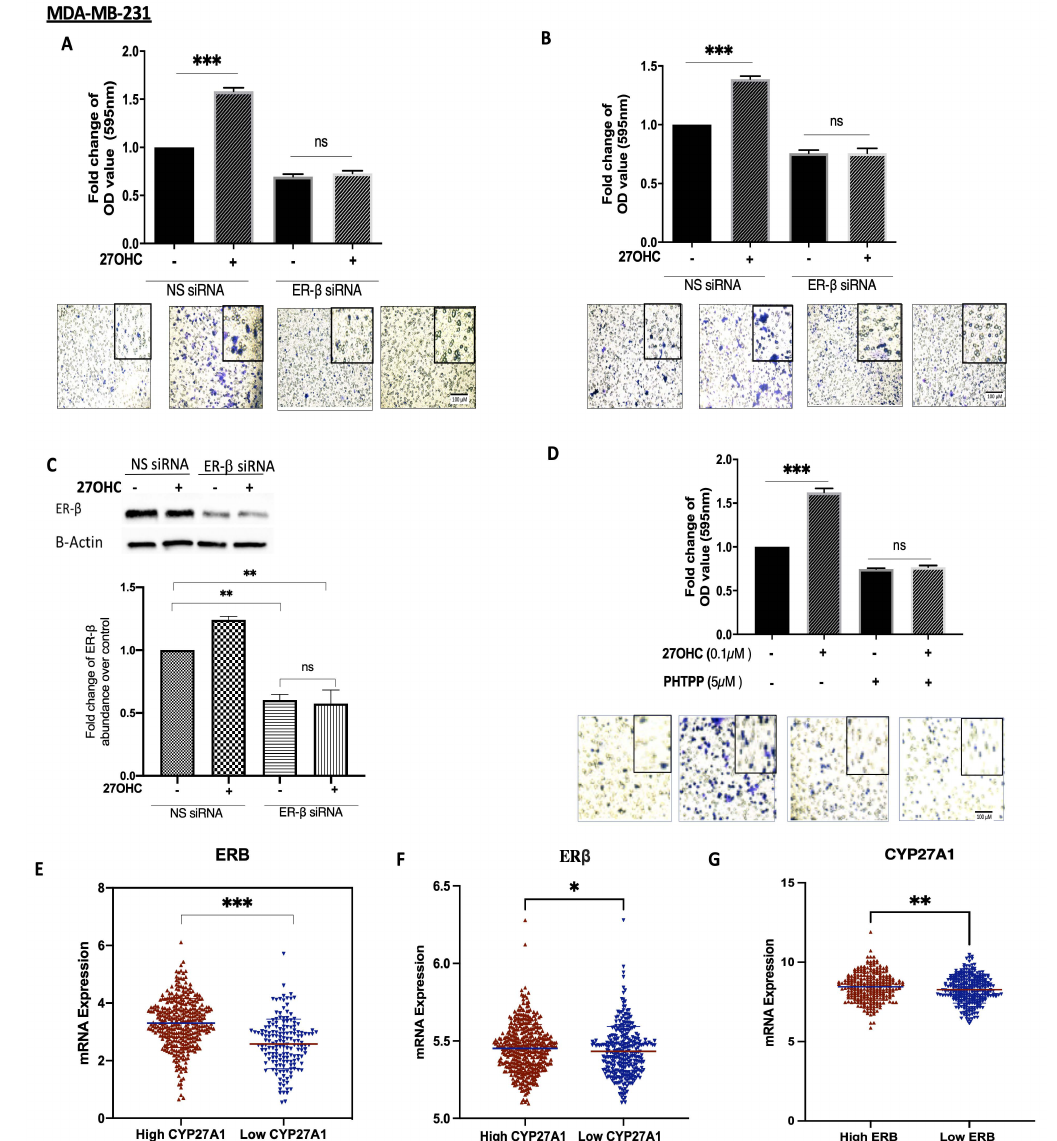
Figure 4. 27OHC increases cell migration/invasion in ER- α -negative breast cancer cells via ER- β . A trans-well assay was used to detect ( A ) migration and ( B ) invasion after 6 h for MDA-MB-231 after being transfected with ER- β siRNA (60 nm) and non-silencing RNA (60 nm) and dosed with 27OHC (0.1 µ M). ( C ) Western blotting was used to detect the abundance of ER- β with or without with ER- β silencing. The densitometry quantification of ER- β was assessed after normalization to β -actin. ( D ) We quantified cell migration after being dosed with 27OHC (0.1 µ M) and PHTPP (5 µ M). The migrated and invaded cells were stained with crystal violet, and images were taken ( × 20 mag- nification). ( E ) Scatterplot analysis of the TCGA data of 504 invasive breast cancer carcinomas for the mRNA expression of ER- β represented as the median expression of CYP27A1. ( F ) Scatterplot analysis of the METABRIC data of 1193 invasive breast cancer carcinomas for the mRNA expression of IGF-I represented as median expression of CYP27A1. ( G ) Scatterplot analysis of the TCGA data of 504 invasive breast cancer carcinomas for the mRNA expression of CYP27A1 represented as the median expression of ER- β . Results are presented as mean +/ − SEM in ( A – D ); in ( E ), the horizontal line presents the mean. p -values were determined by using the one-way statistical analysis of Graph- Pad Prism: one-way ANOVA followed by least significant difference (LSD) post-hoc test (* p < 0.05, ** p < 0.01, *** p < 0.001) ( A – D ); ( E ) Mann–Whitney test. Scale bar represents 100 µ